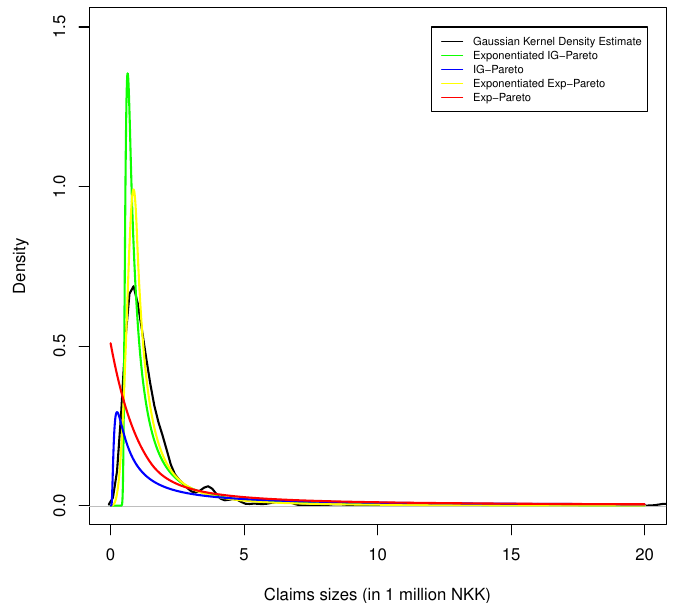
Figure 7. Kernel density estimate of Norwegian fire insurance data, for 1990, with corresponding exponentiated exp-Pareto, exp-Pareto, exponentiated IG-Pareto, and IG-Pareto fit.